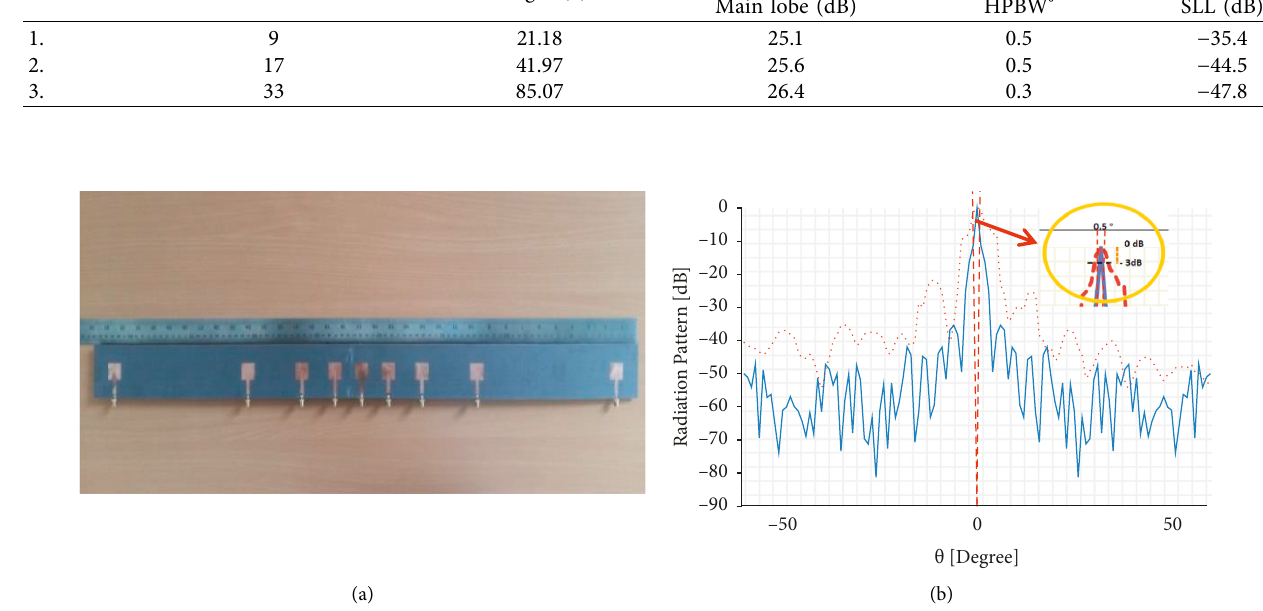
Figure 7: Comparison of simulation and measurement of 9-element sparse array